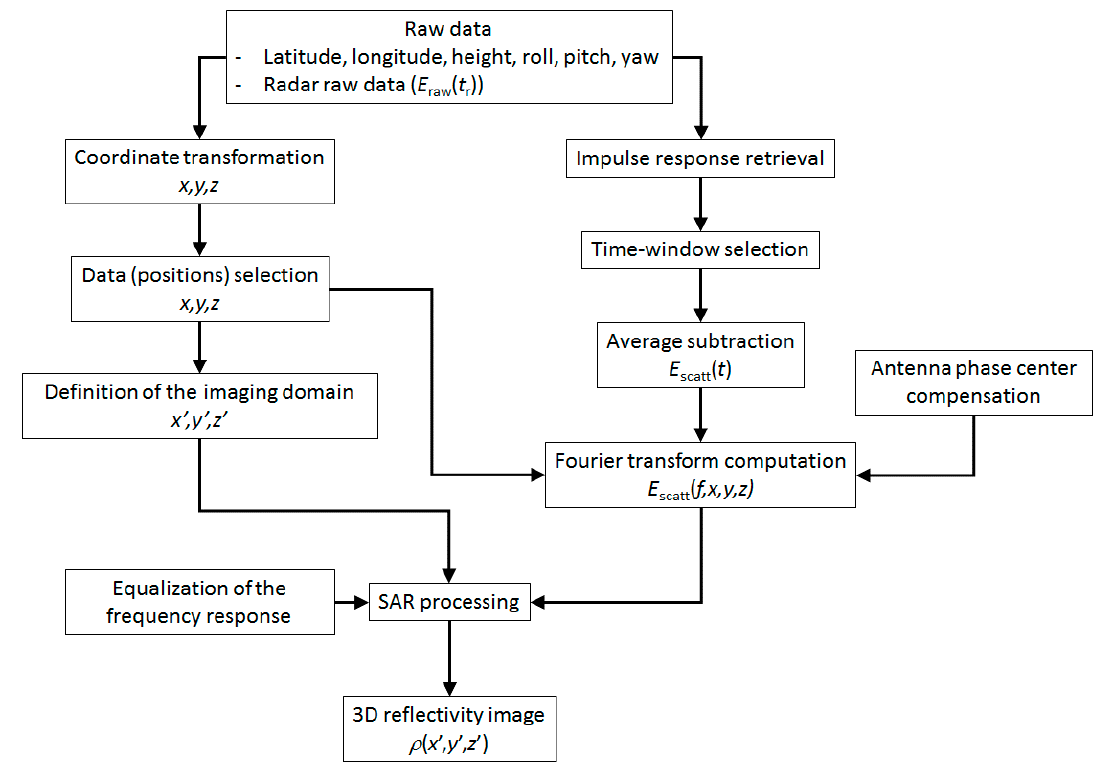
Figure 4. Flowchart of the GPR system processing algorithm.